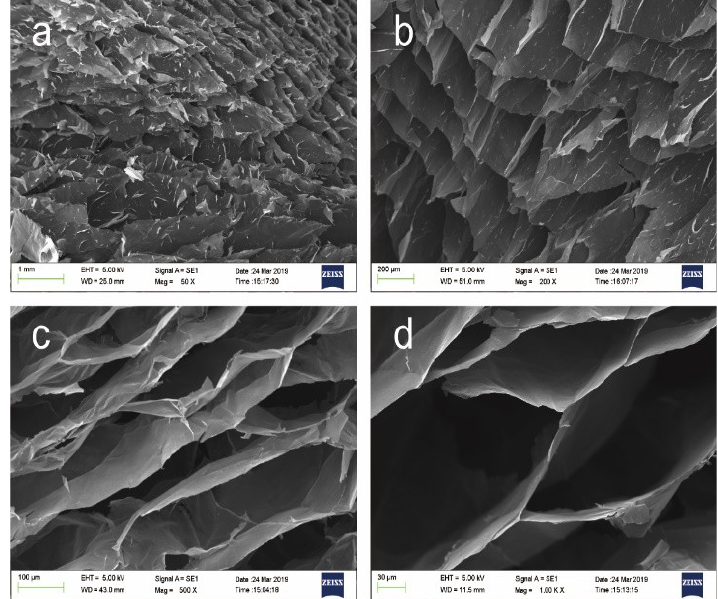
Figure 3. SEM images of local magnification of AGA. ( a ) and ( b ) are the side views of the AGA, and ( c ) and ( d ) are the top views of the AGA